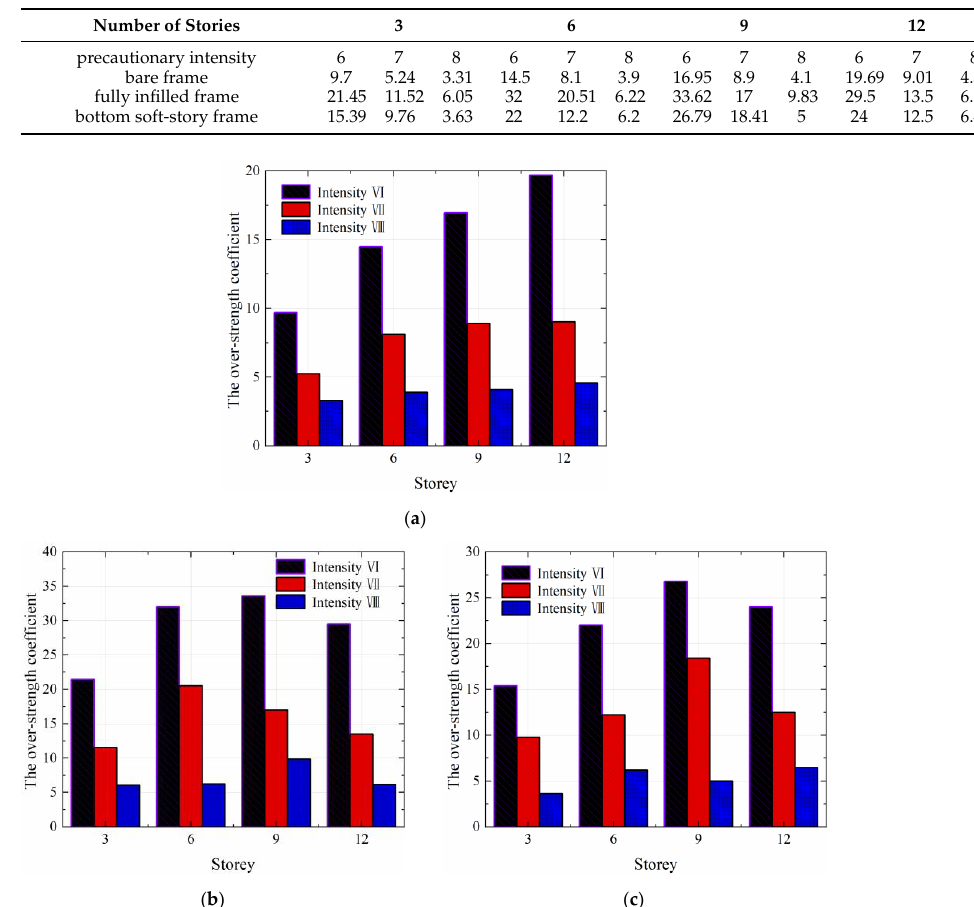
Figure 9. Over-strength coefficient values of 36 RC frame structures: ( a ) bare frame; ( b ) fully infilled frame; ( c ) bottom soft-story infilled frame.